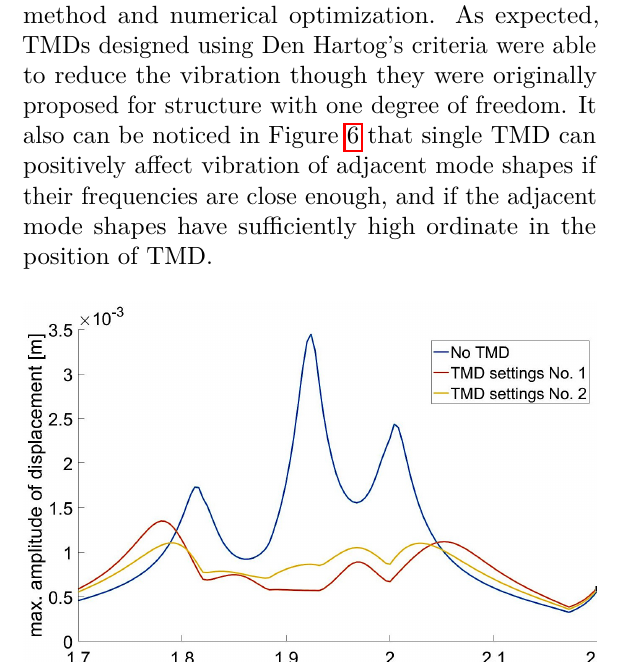
Figure 8. displacement of TMDs - settings No.